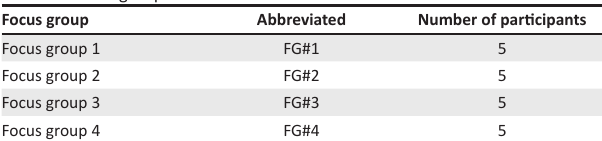
TABLE 3: Focus group.